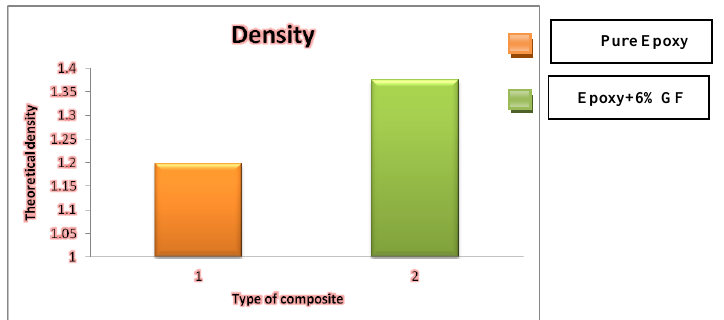
Fig.7: Theoretical density of Epoxy +6% glass fiber composites and pure epoxy.